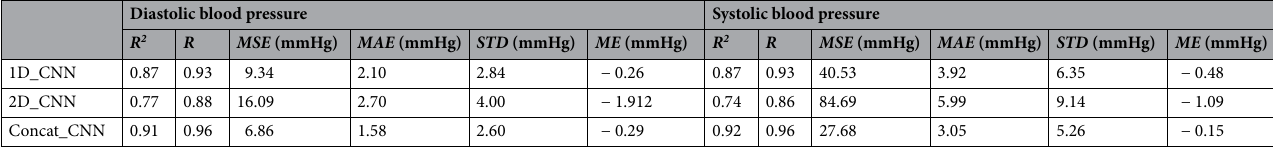
Table 1. Comparison of proposed approach results presented in estimating SBP and DBP.